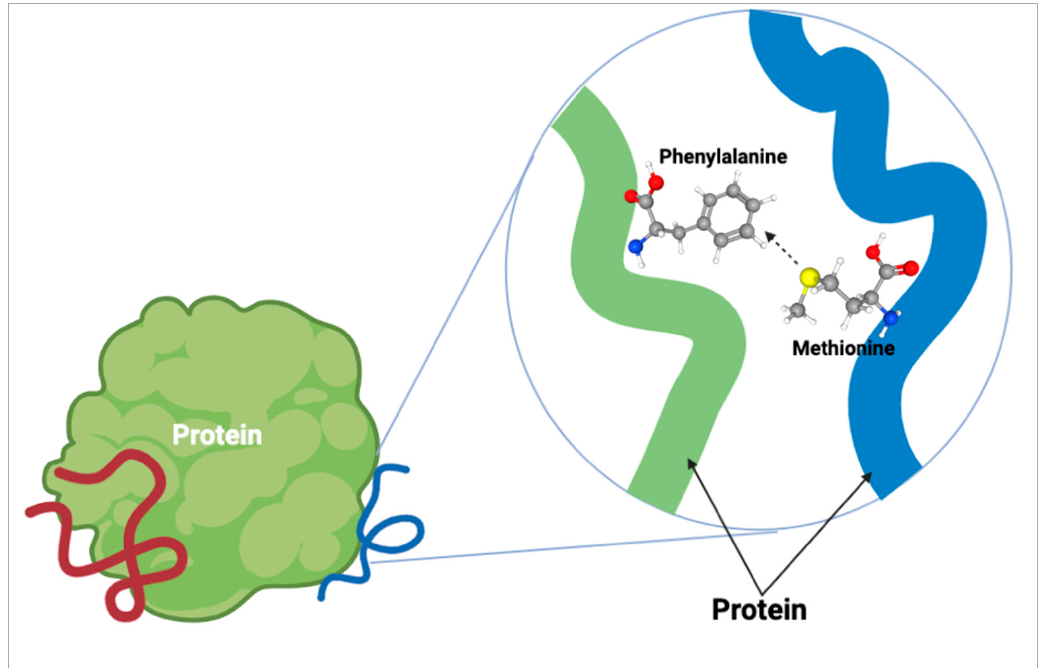
Figure 3. Methionine S-aromatic motif. The formation of an S-aromatic motif within proteins occurs between the sulfur atom (yellow ball) of amino acids such as methionine and an aromatic residue, such as phenylalanine, within proteins. These interactions are quite common within proteins and aid in stabilization.